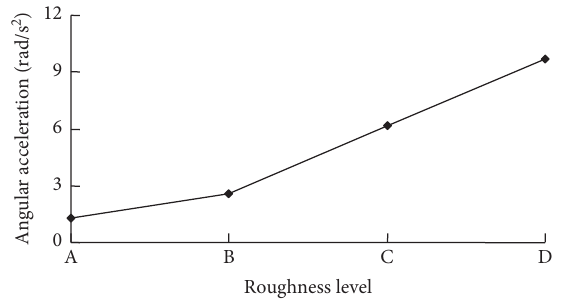
Figure 12: The variation curve of peak values of pitching vibration accelerations of the vehicle body.